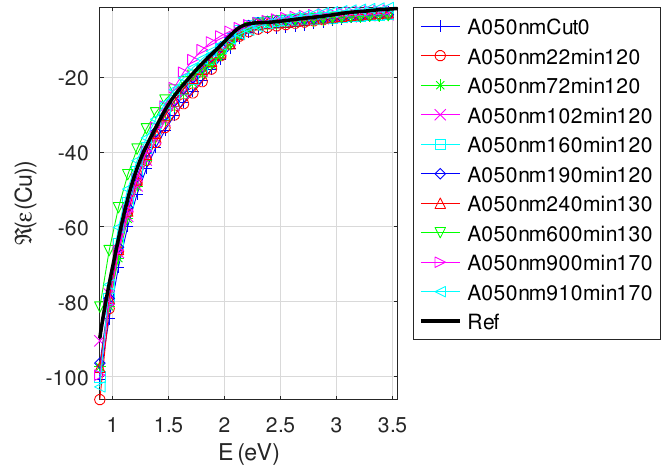
Figure A12. Real part of the relative permittivity of copper as a function of the photon energy: bulk (black) and best calculated (color) for each oxidized sample (initial thickness h 0